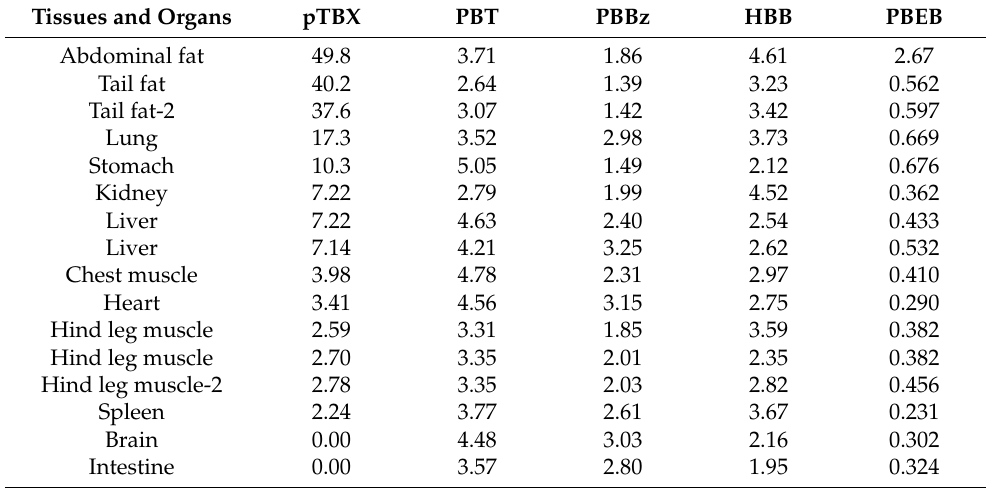
Table 2. NBFRs biomagnification factors in the organs and tissues of sheep. Tissues and Organs pTBX PBT PBBz